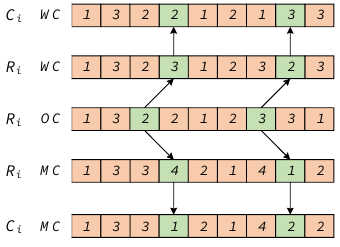
Figure 4. Self-updating process for individual machine–worker.